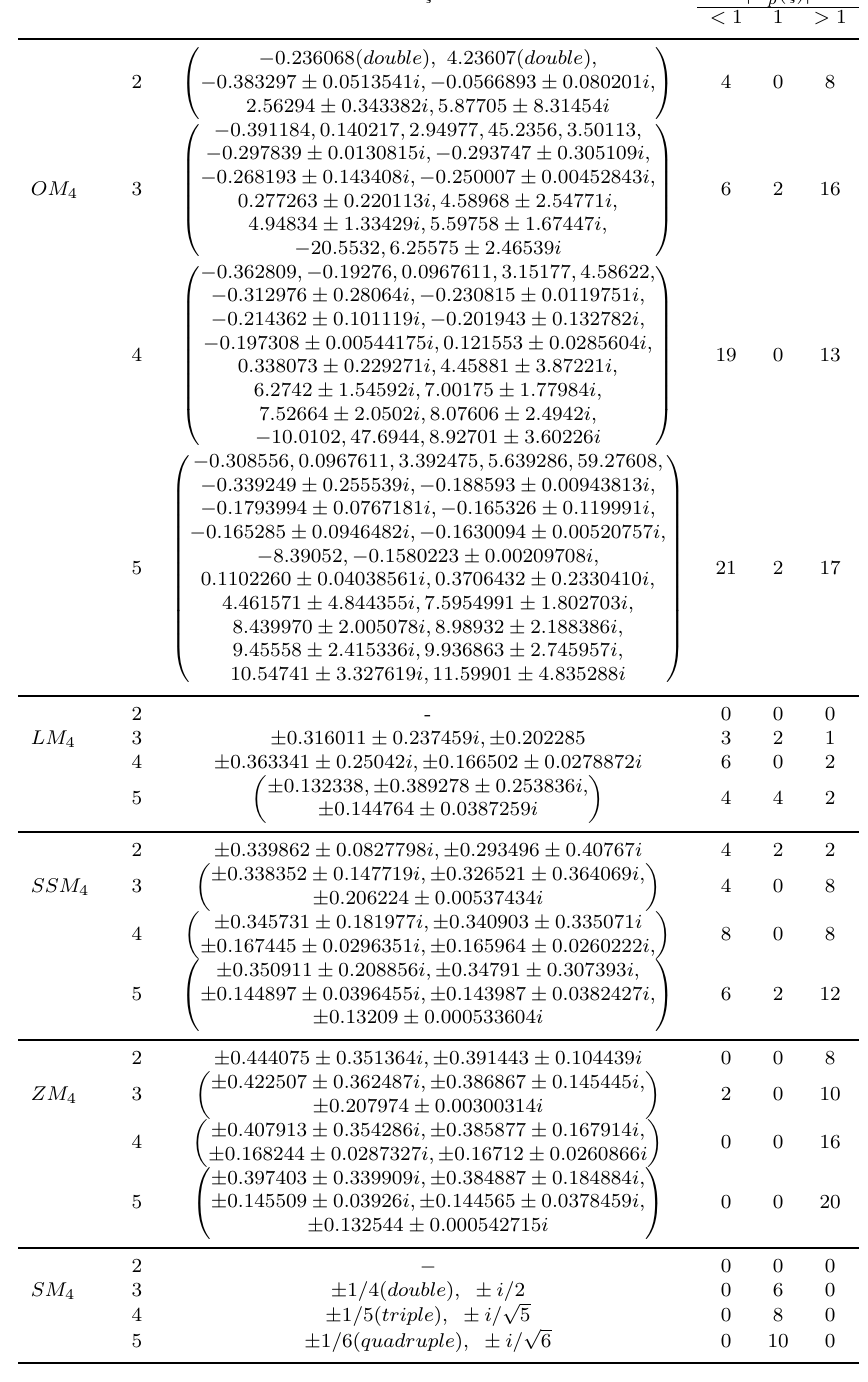
Table 2. Extraneous fixed points ξ with stability check for selected cases with 2 ≤ m ≤ 5 Method